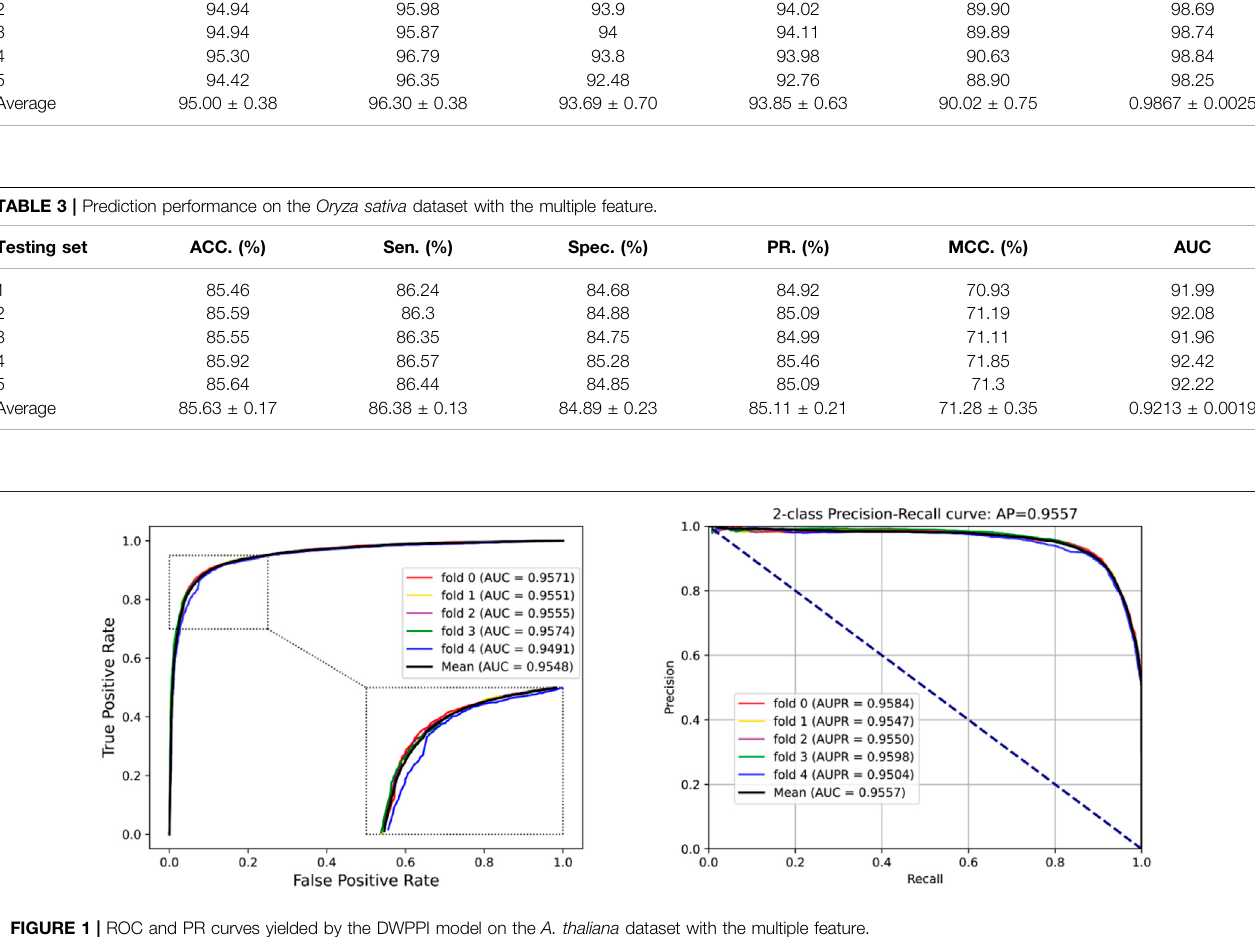
Frontiers in Bioengineering and Biotechnology |